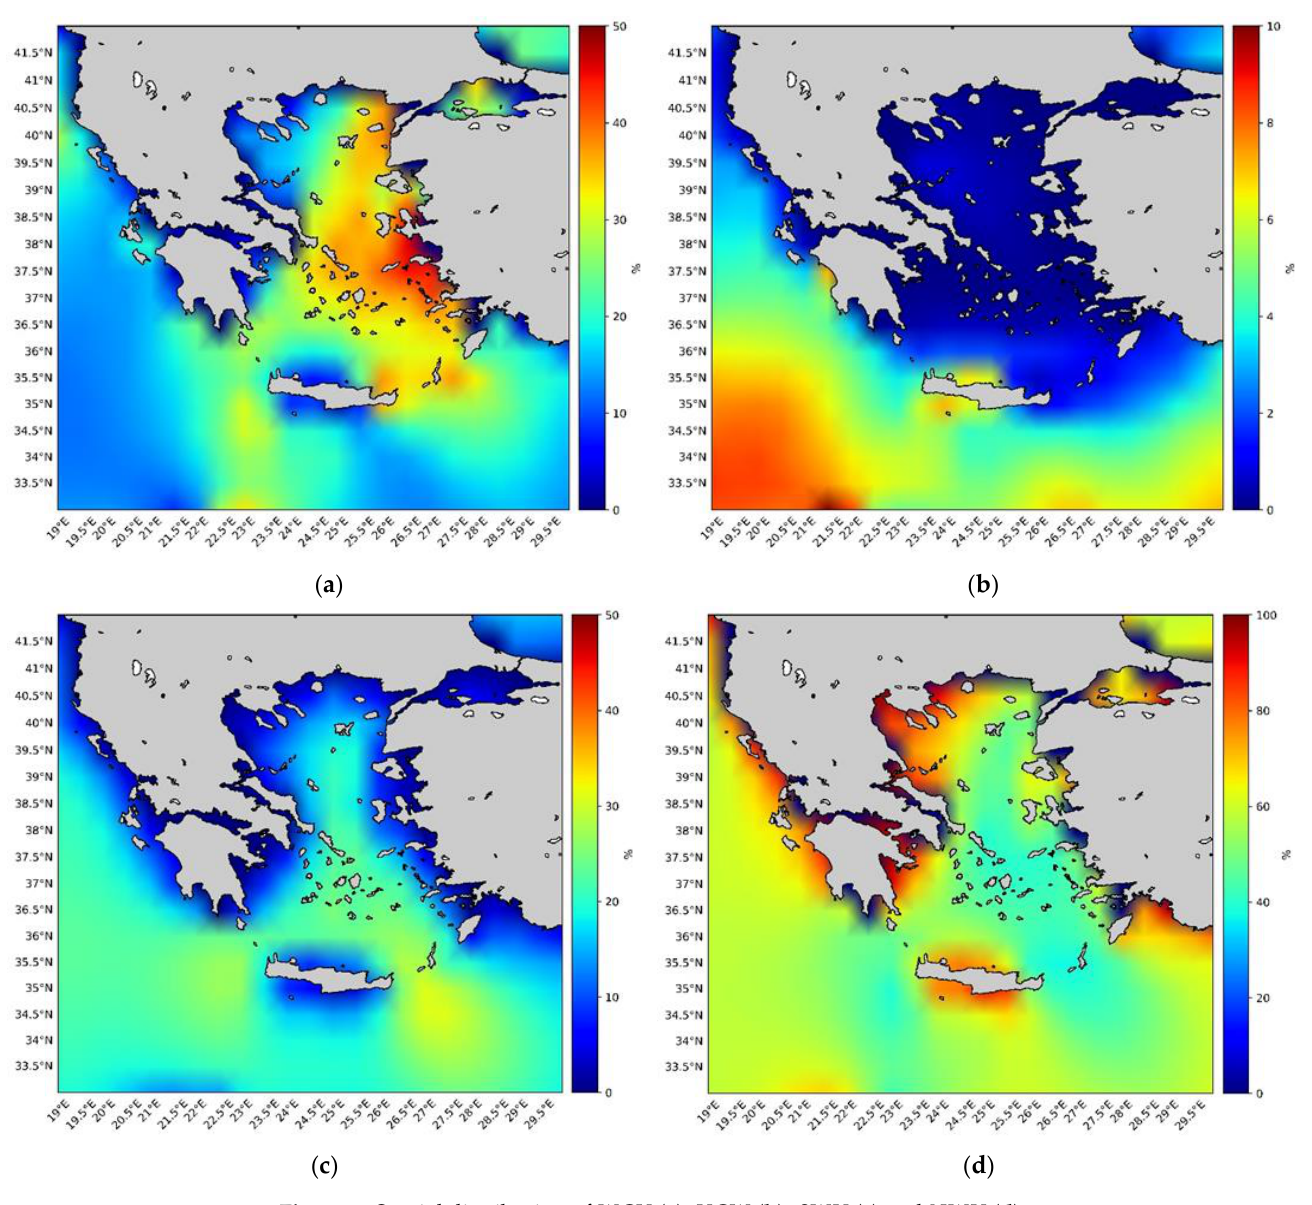
Figure 6. Spatial distribution of 𝑊𝐶𝑉 ( a ), 𝑉𝐶𝑊 ( b ), 𝑆𝑊𝑉 ( c ) and 𝑈𝑊𝑉 ( d ).